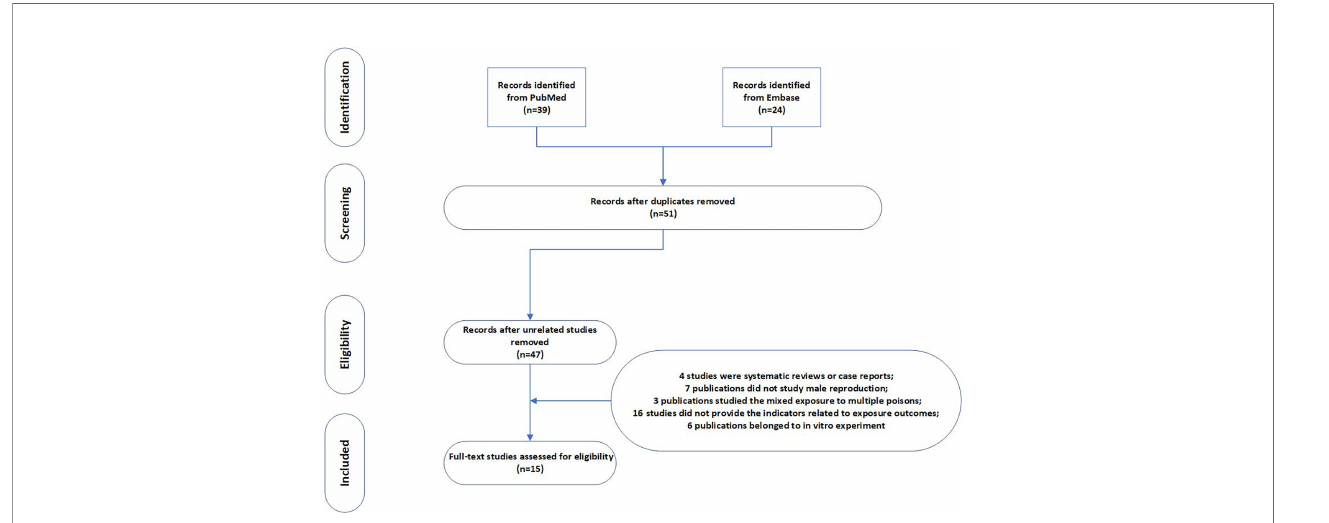
FIGURE 1 | Flow diagram of literature search strategy for the meta-analysis.